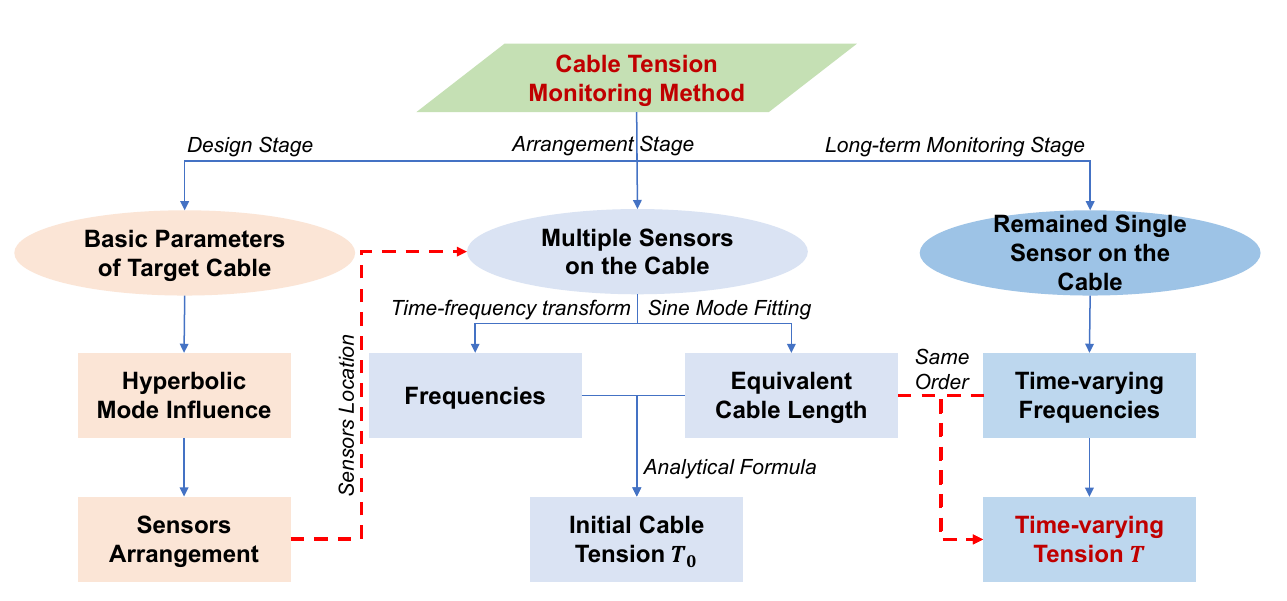
Figure 4. long-term cable tension monitoring procedure.